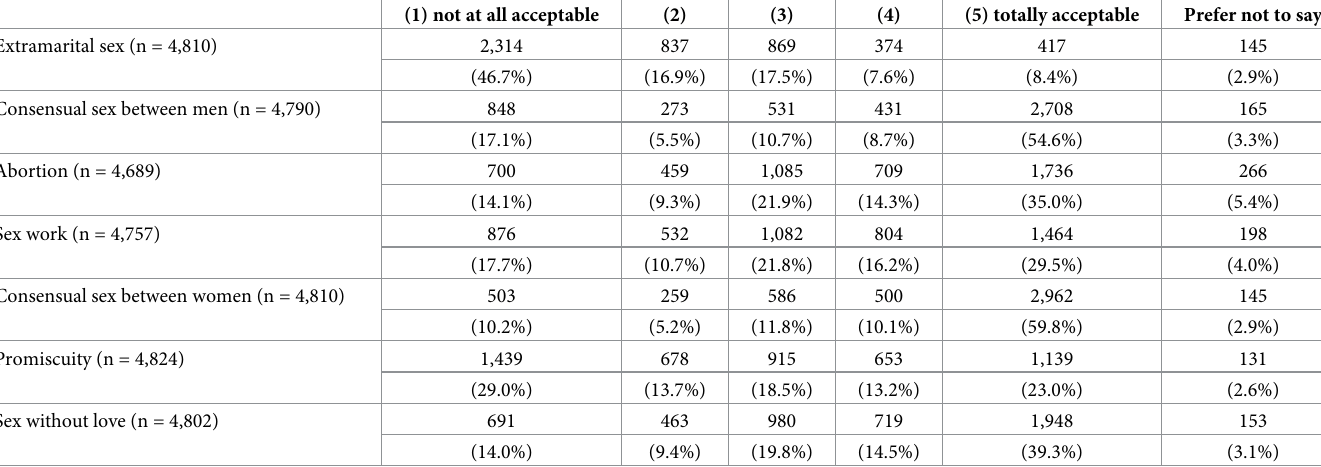
Table 2. Acceptance regarding sexual behavior (weighted sample): German Health and Sexuality Survey